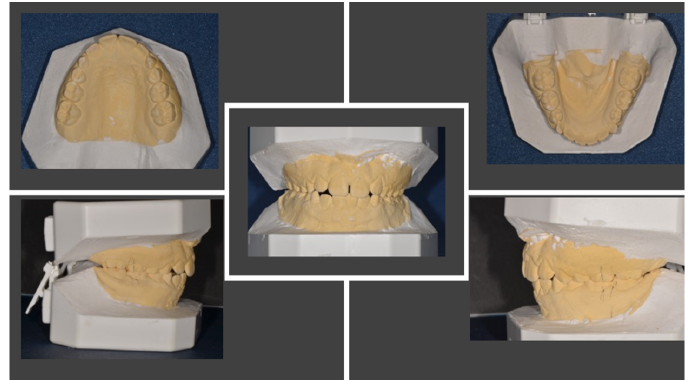
Figure 4. Study models before orthodontic therapy.